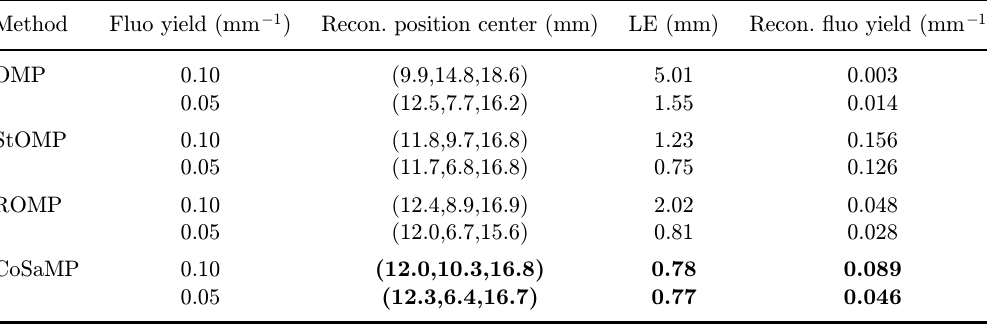
Table 4. Reconstructed results of double targets with di®erent °uorescence yields.